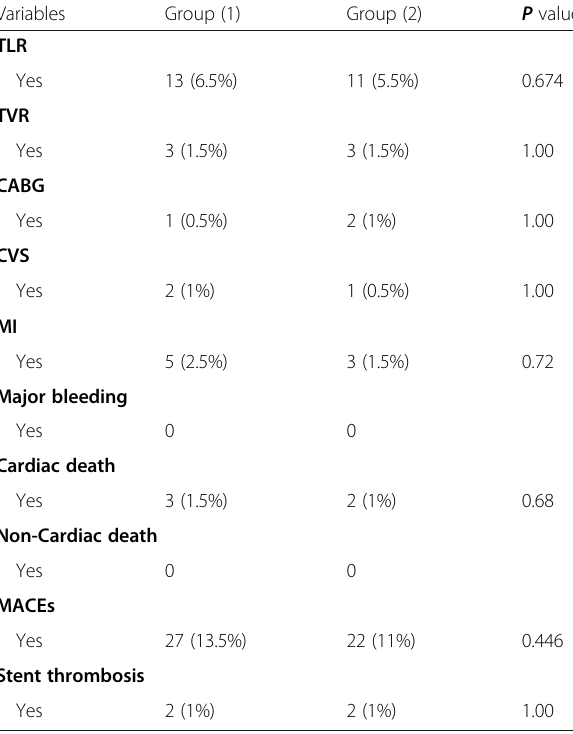
target lesion revascularization, TVR target vessel revascularization